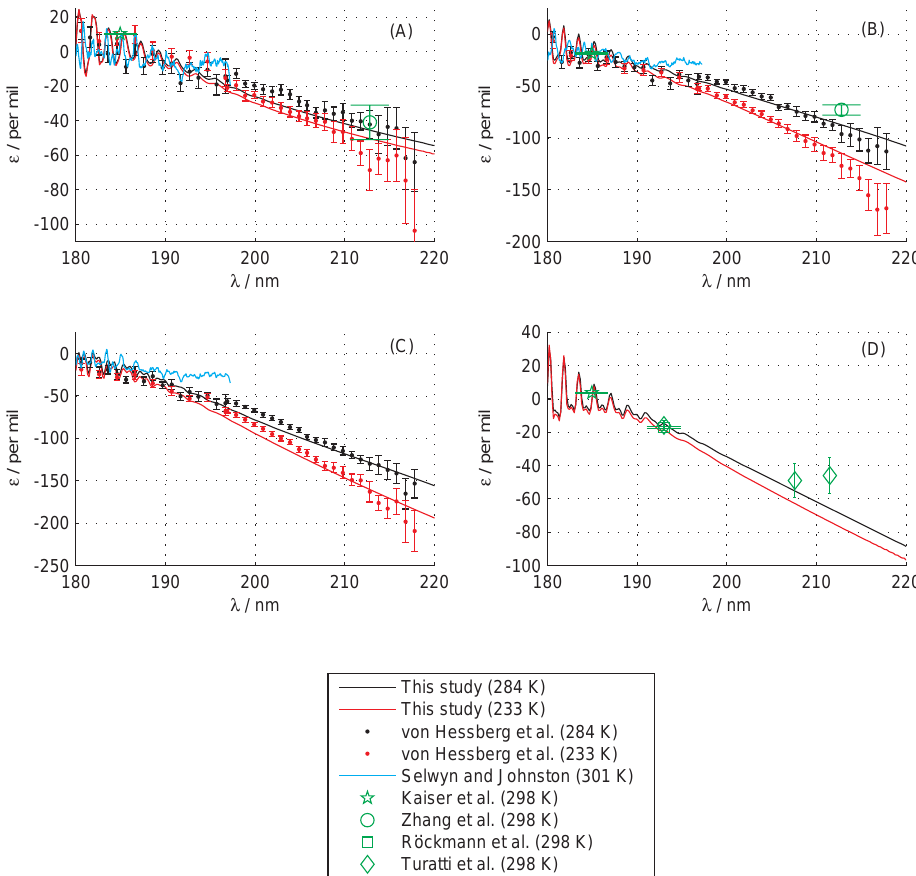
Fig. 3. The fractionation constants for 15 N 14 N 16 O (Panel A ), 14 N 15 N 16 O (Panel B ), 15 N 216 O (Panel C) and 14 N 218 O (Panel D) at different temperatures compared to experimental results of von Hessberg et al. (2004), Selwyn and Johnston (1981), Kaiser et al. (2003), Zhang et al. (2000), R¨ockmann et al. (2000) and Turatti et al. (2000). The legend applies to all panels, however the results of this study in Panel d were calculated at 300K (black) and 220K